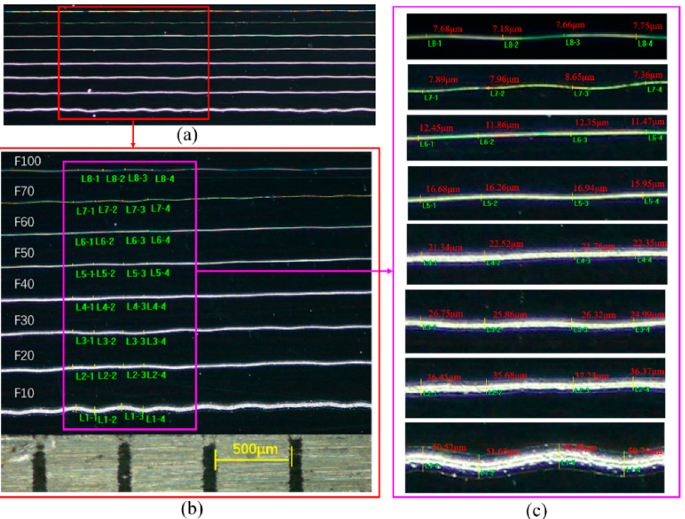
Figure 10. Variation of deposition line width under different moving speeds. ( a ) the variation of deposition eight lines under different moving speed; ( b ) four position points were selected for each deposition line; ( c ) the line width measured data of each deposition line.